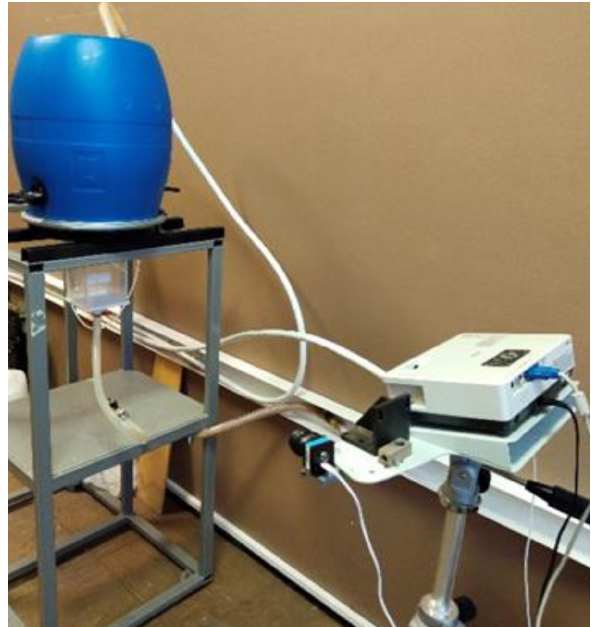
Figure 2. Experimental setup for calibration testing